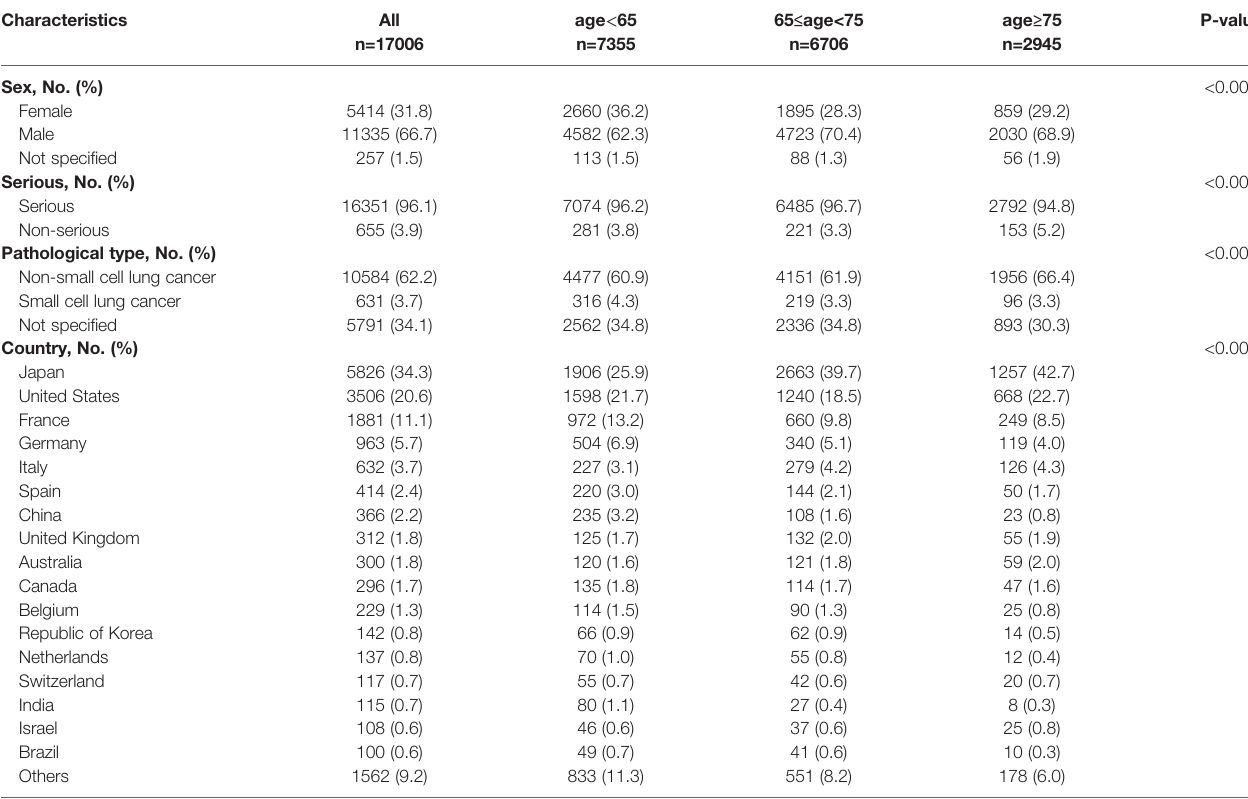
TABLE 1 | Characteristics of 17006 Patients.